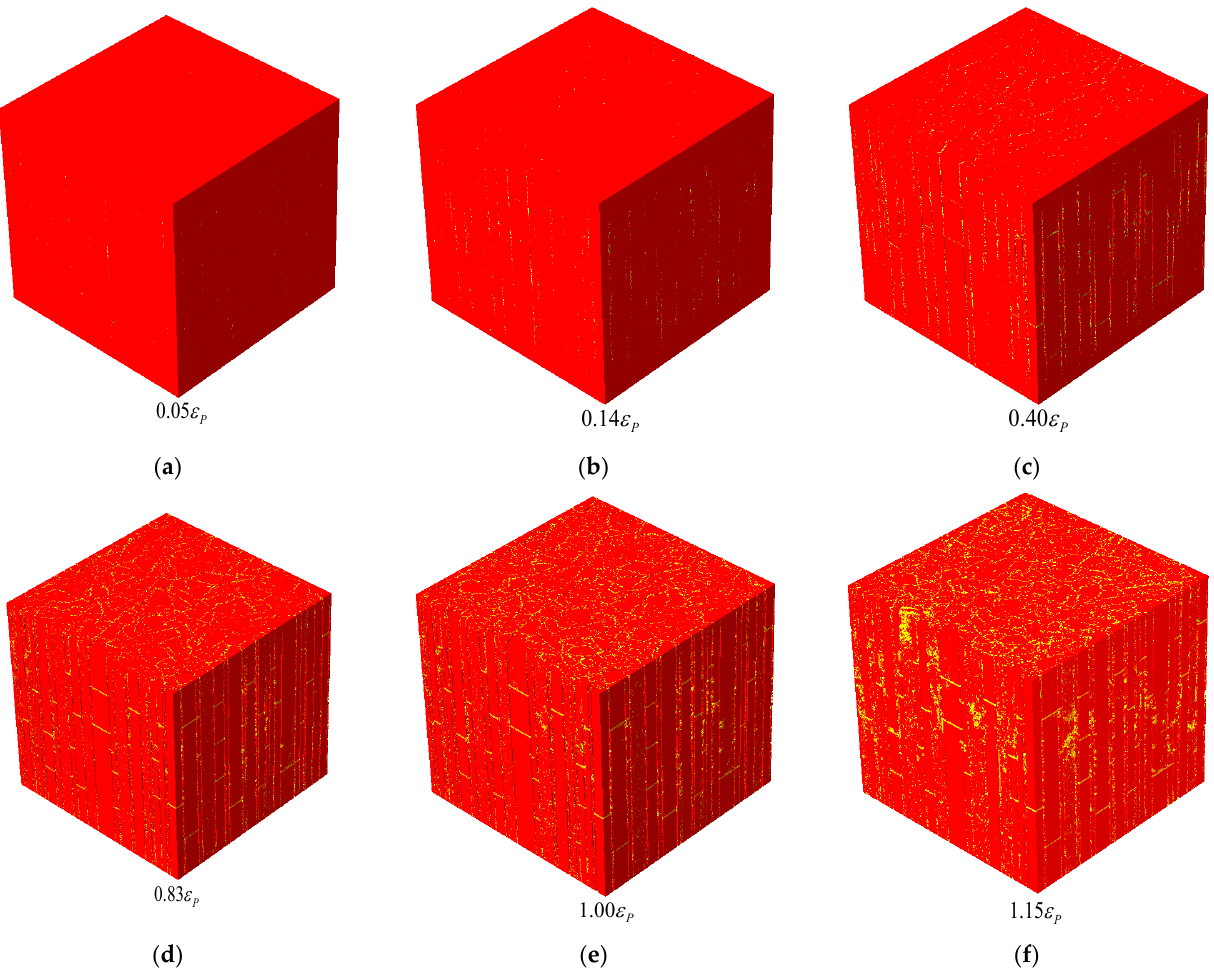
Figure 16. Damage evolution in columnar jointed basalt, where the yellow spots represent the damage occurrence and transparent means that the element is completely damaged, ( a – f ) correspond to points A–F in Figure 15.